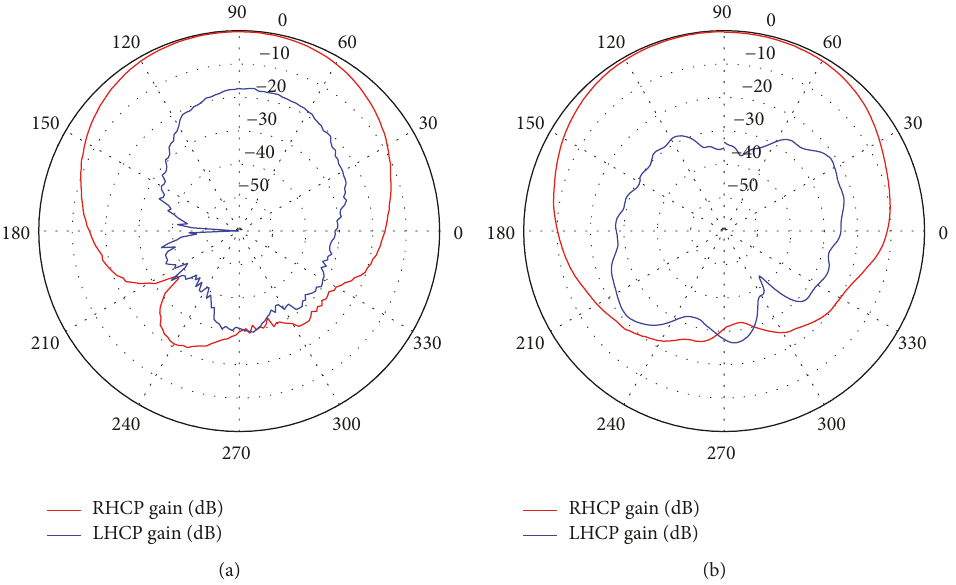
Figure 5: In this figure, all of the data is measured in an anechoic chamber. Elevation angles ranged (𝜋,2𝜋) in the figure denote negative elevation angle. (a) is the radiation pattern of antenna Ashtech. (b) is the radiation pattern of antenna